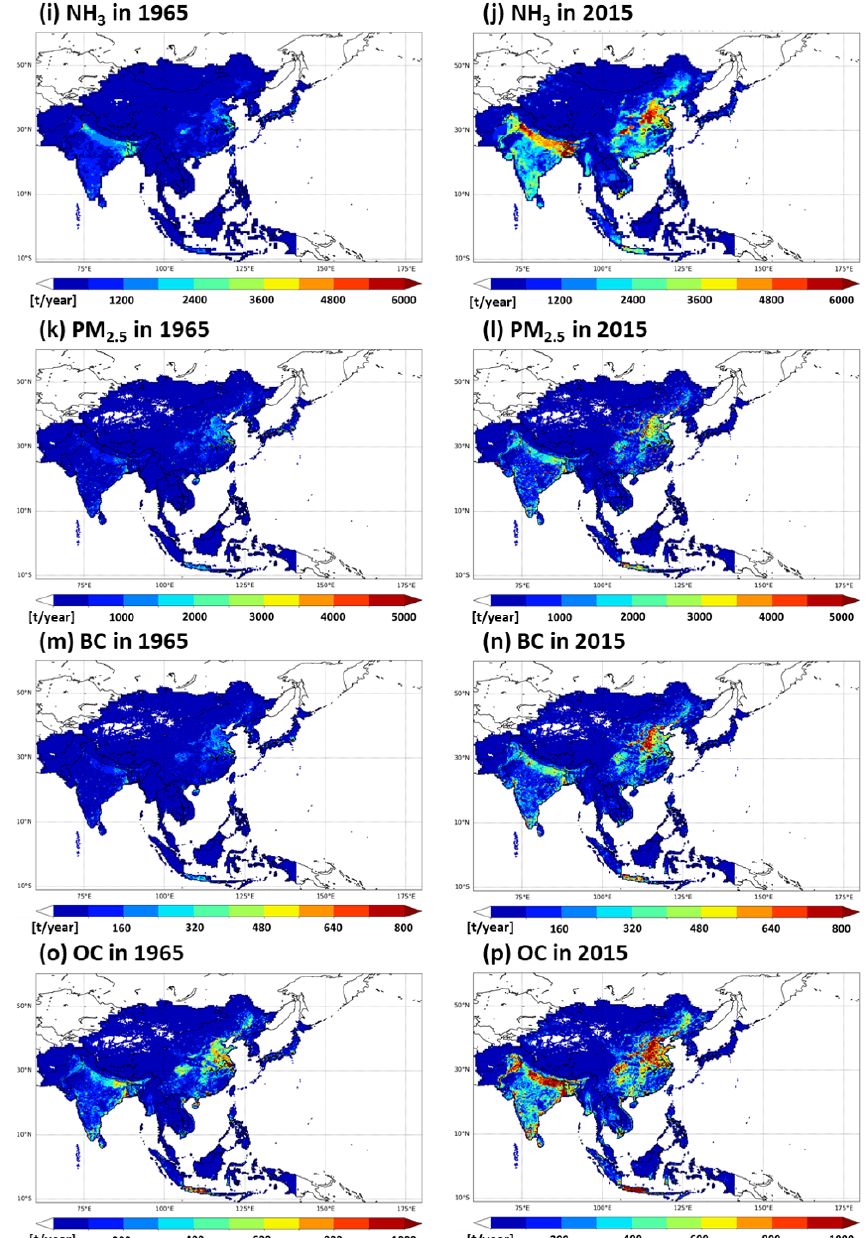
Figure 8. Grid maps of annual emissions of (a, b) SO 2 , (c, d) NO x , (e, f) CO, (g, h) NMVOCs, (i, j) NH 3 , (k, l) PM 2 . 5 , (m, n) BC, and (o, p) OC in 1965 (left panels) and 2015 (right